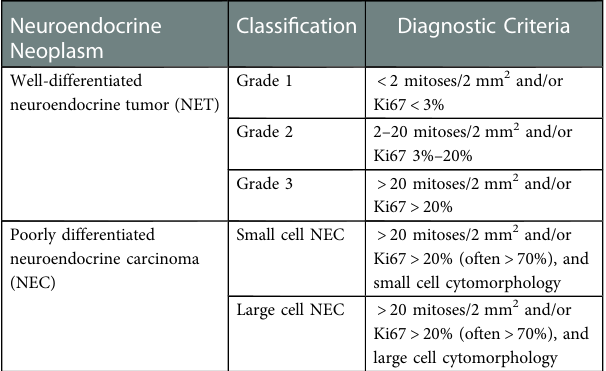
TABLE 3 WHO 2022 classi fi cation system for neuroendocrine tumors. Neuroendocrine